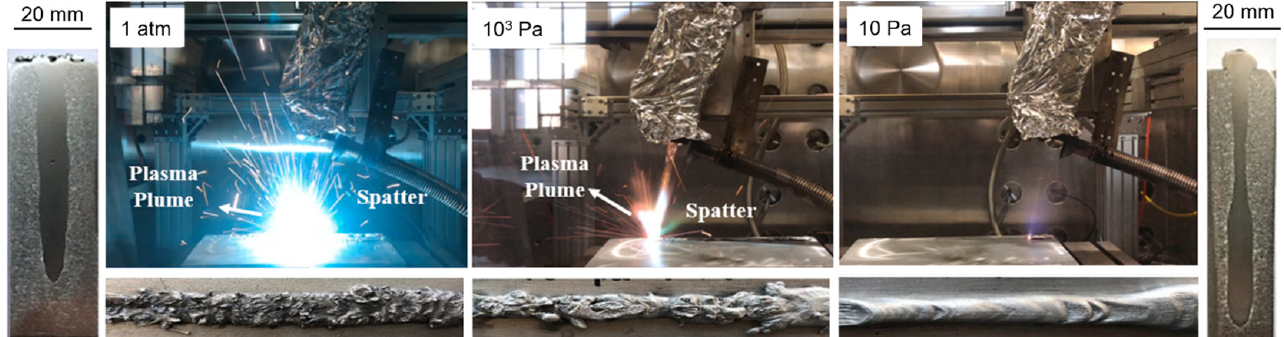
Figure 7. Effect of ambient pressure on size of plasma/weld plume and penetration depth in welding of 30 kW Yb:fiber laser beam of thick Al alloy. After Wang et al. [112].